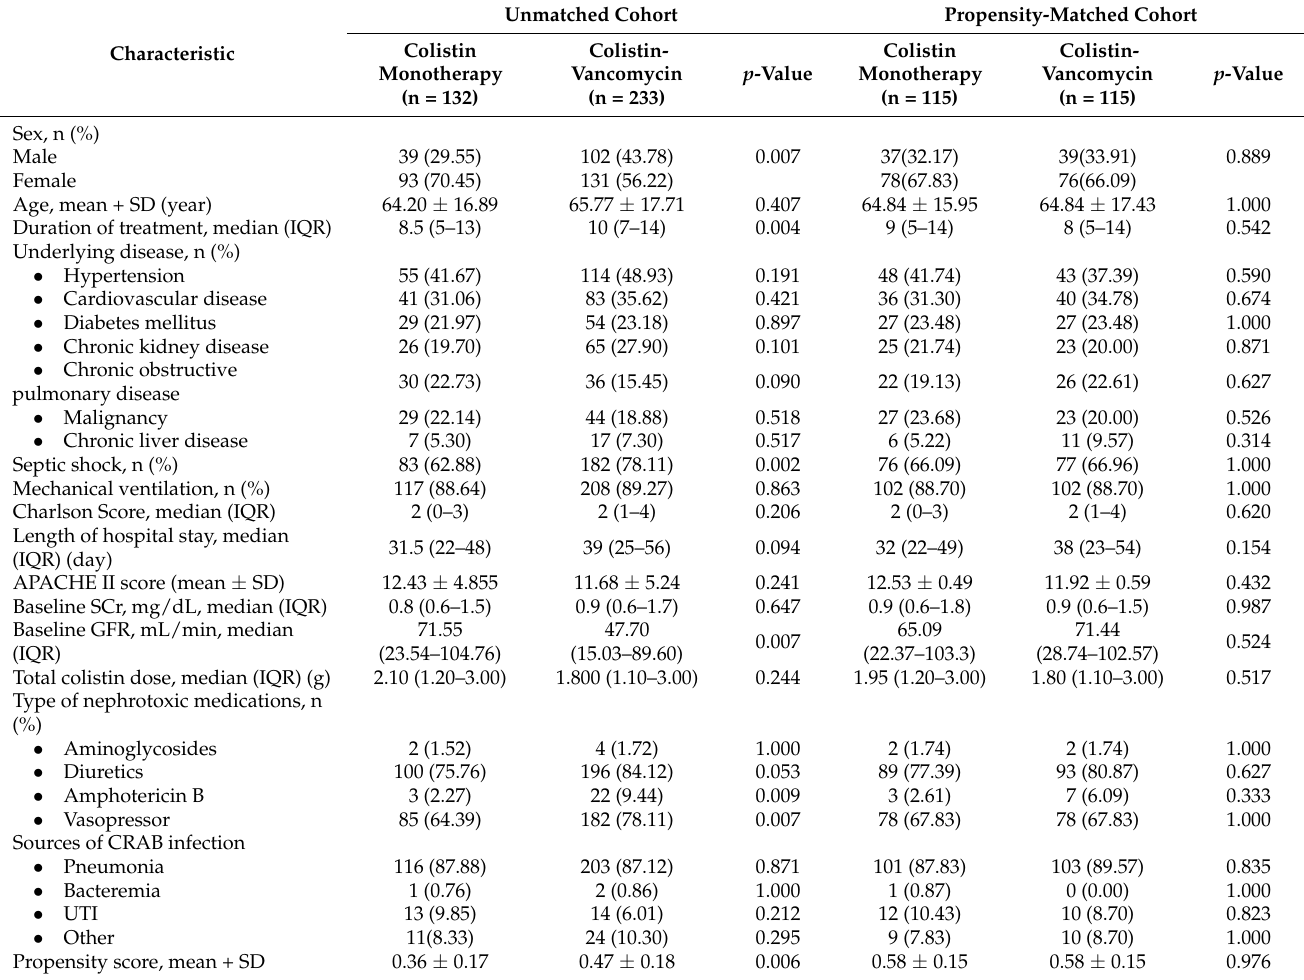
Table 1. Demographic and clinical characteristics of patients who received colistin monotherapy compared to colistin- vancomycin combination